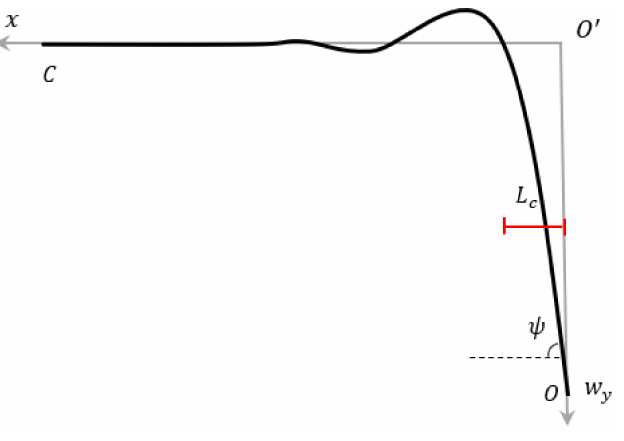
Figure 2. High curvature length ( L c ) of the pipeline based on deflection w y